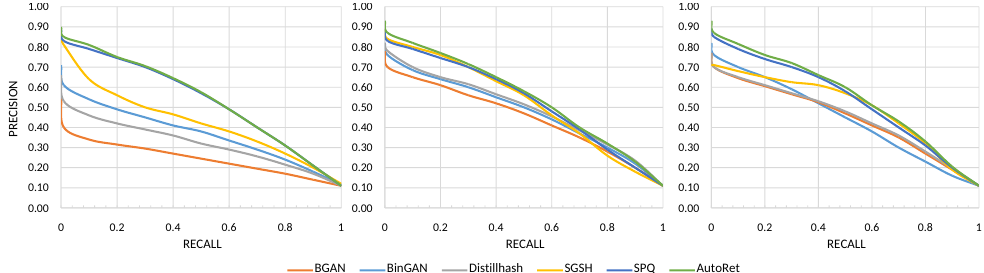
Figure 6. The figures illustrate precision-recall graphs measured on CIFAR-10, MIRFlickr-25K, and NUS-WIDE, respectively.